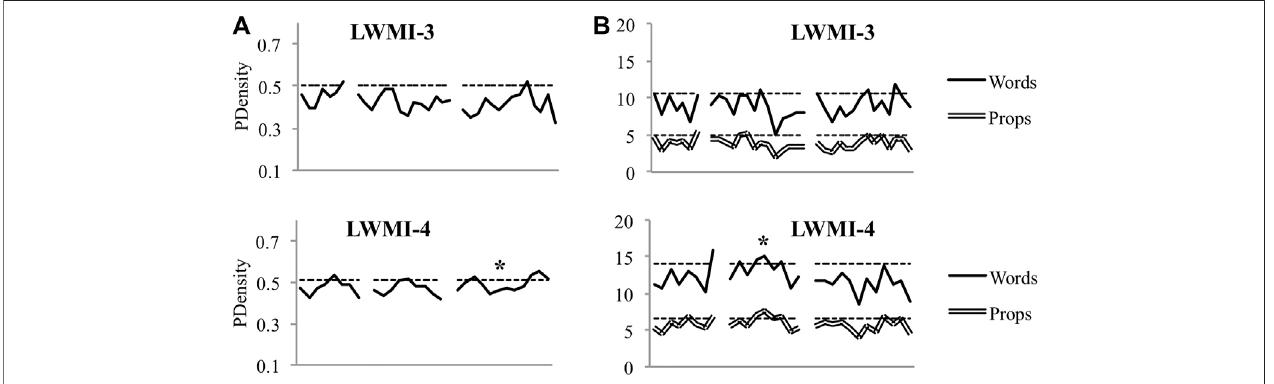
FIGURE 6 | Sentence Combining probe for participants with language and working memory impairments (LWMI). Graphs represent three scores averaged over each session: the ratio of propositions to words [propositional density; (A) left column], words per trial, and propositions per trial (B). Dashed line represents 1 SD above